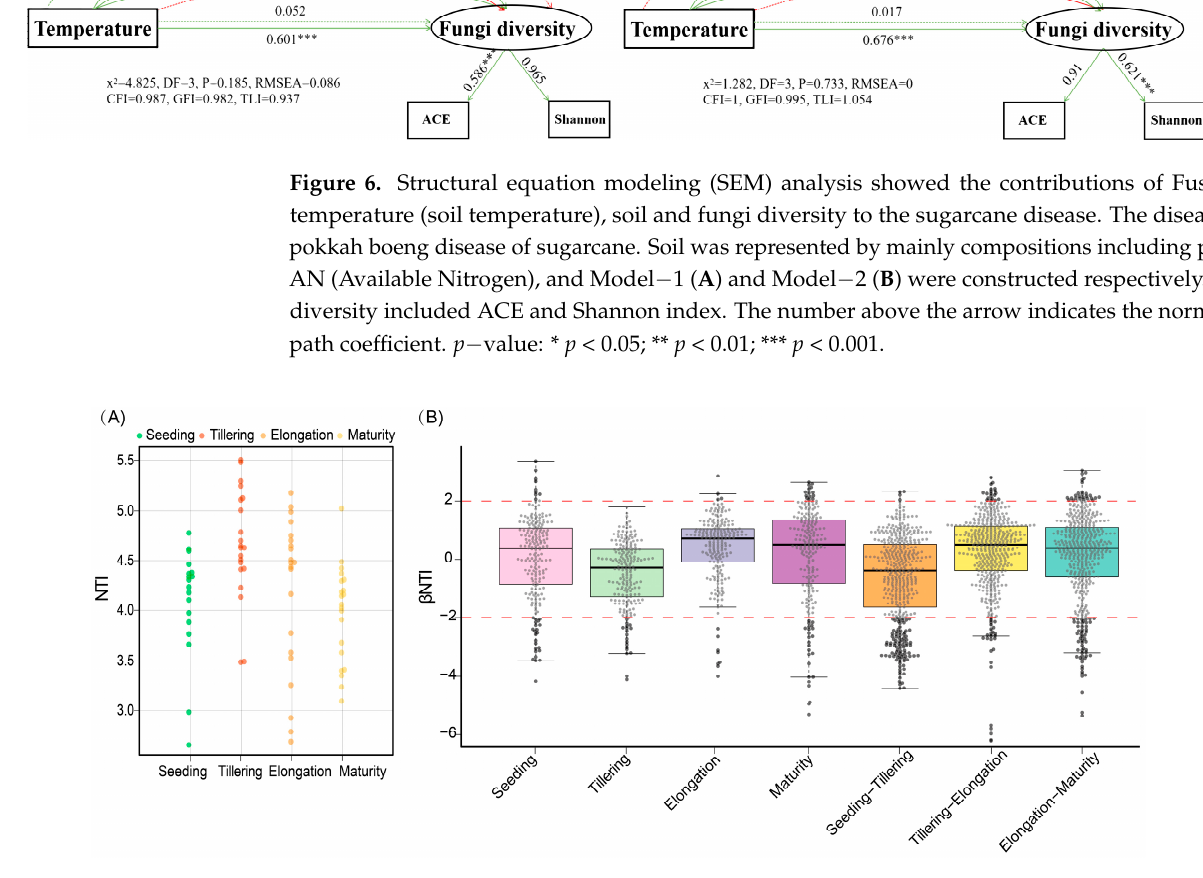
Figure 7. The distribution of NTI values ( A ) and box plots of β -NTI ( B ) for rhizosphere soil samples of sugarcane at di ff erent fertility stages, with di ff erent colors representing sample groups at di ff erent periods and red dashed lines marking the intervals of − 2 and 2.